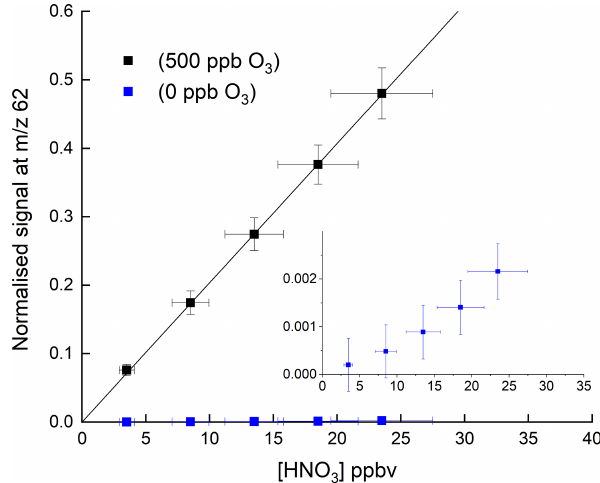
Figure 2. HNO 3 detection at m/z 62 in the absence and presence (500ppbv) of O 3 . The solid lines are non-weighted, linear regres- sions to the data and are 2 . 035 × 10 − 2 and 8 . 033 × 10 − 5 ppbv − 1 HNO 3 when 500ppbv O 3 and zero O 3 were present, respectively. The inset (same x and y axes as in the full figure) is an expanded view of the signal obtained in the absence of O 3 . The error bars rep- resent 15% systematic uncertainty in the HNO 3 concentration and 2 σ statistical uncertainty in the signal at m/z